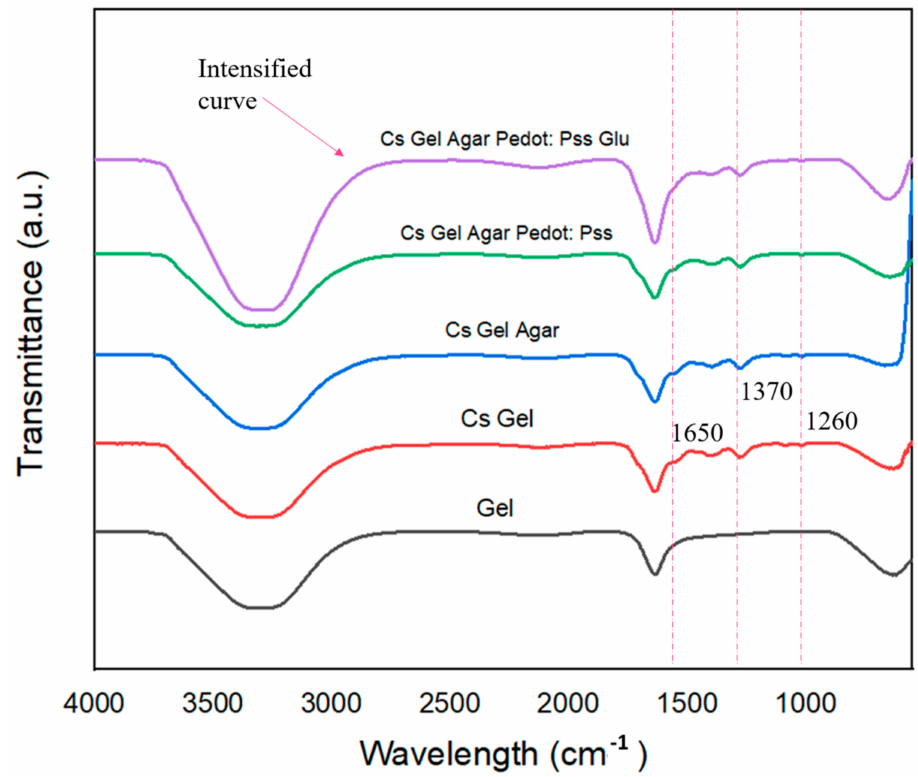
Figure 12. ATR–FTIR plots of hydrogel